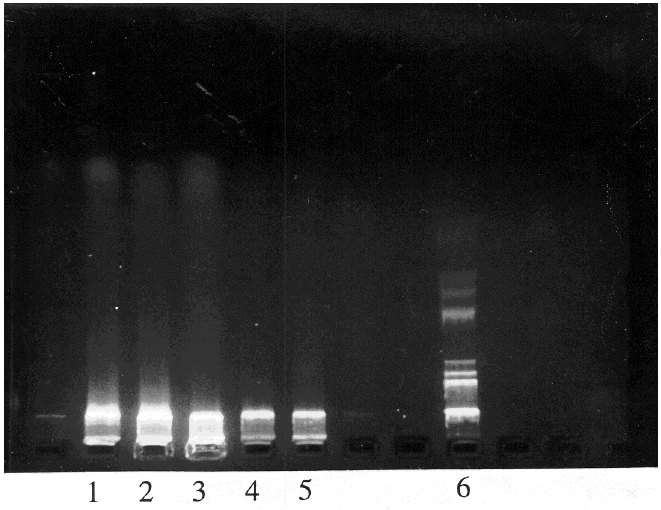
Fig. 3. Electrophoretic analysis of DNA fragments on a 1.5% agarose gel. Lane 1, Ca with DI 0.85; lane 2, Ca with DI 1.25; lane 3, Ca with DI 1.72; lane 4, Ca with DI 2.51; lane 5, Ca with DI 2.69; lane 6, standard DNA ( λ EcoRI/Hind III digest 125 bp–22 kbp). Ca, carcinoma; DI, DNA